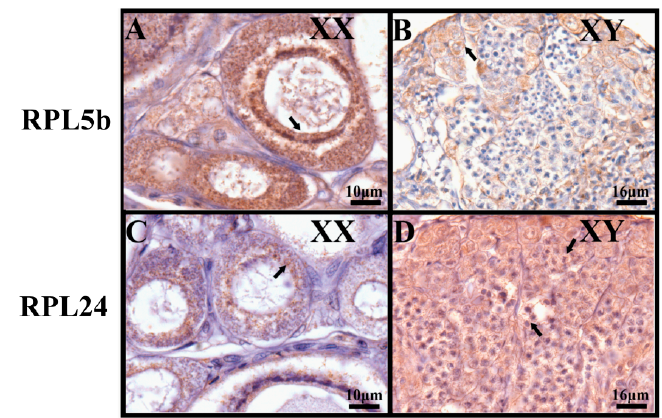
Figure10. Sexually dimorphic expression of RPL5b and RPL24 in tilapia ovary and testis